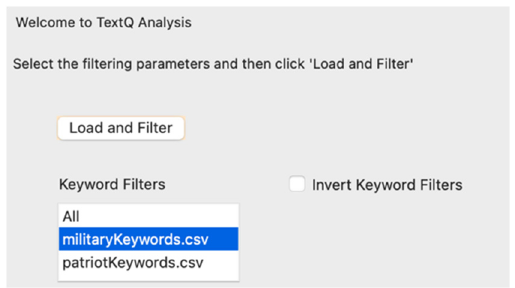
Figure 5. Options panel presented to the